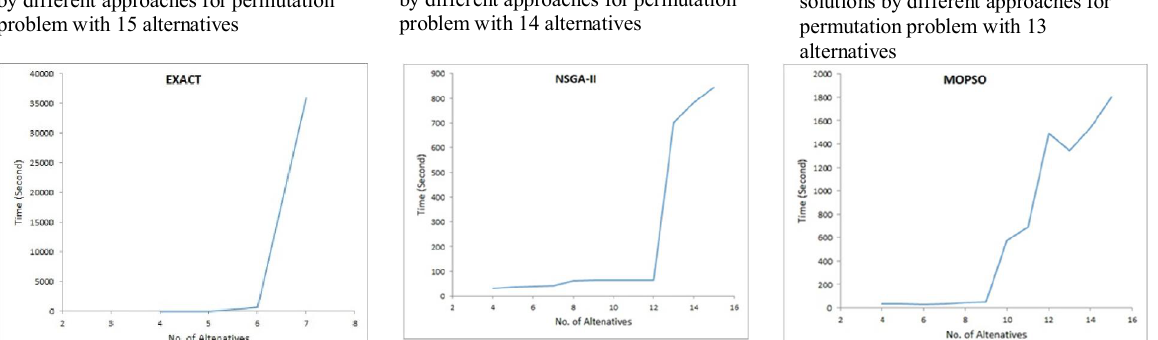
Fig. 13. Extracted non-dominated solutions by different approaches for permutation problem with 14 alternatives